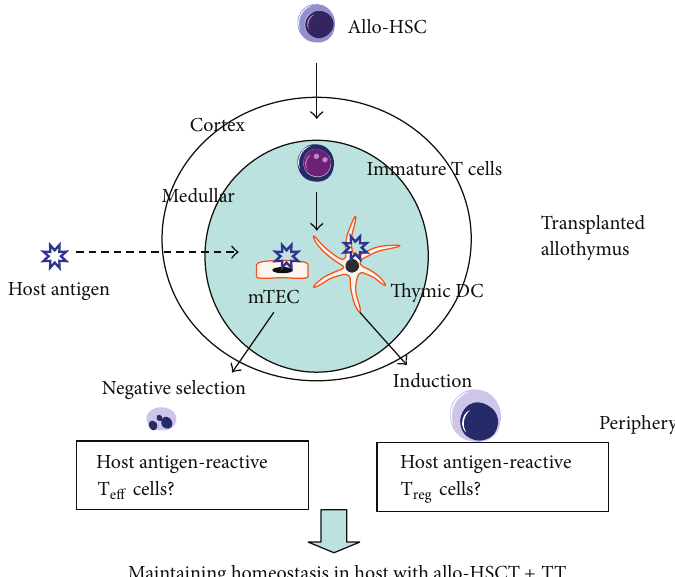
Figure 3: Immune regulation to maintain homeostasis by allo-HSCT +